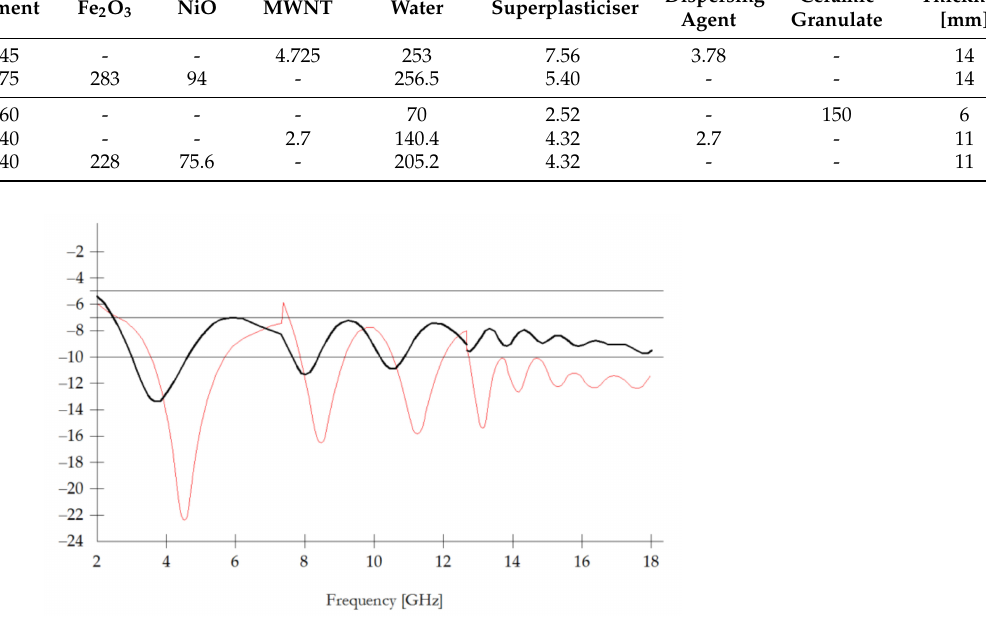
Figure 9. Reflectivity versus frequency for two-layer panels (black) and three-layer panels (red) (after [57]).